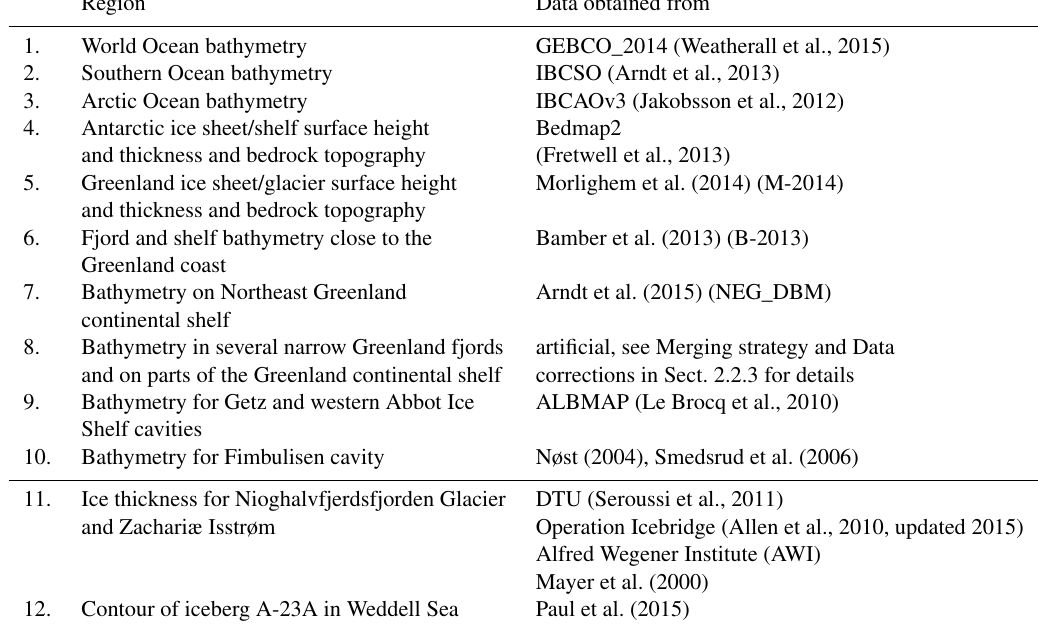
Table 1. Data sources for individual regions merged in RTopo-2. The index numbers correspond to the source flags in Fig.